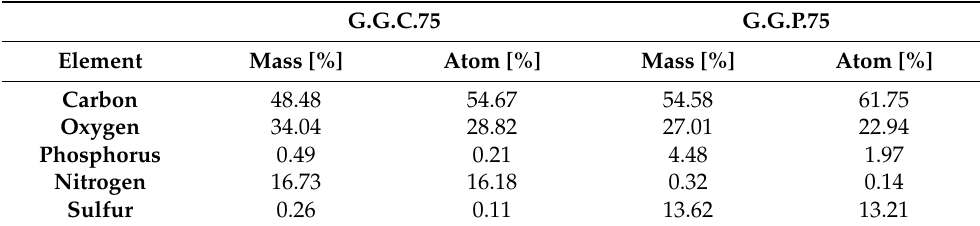
Table 9. Composite microstructure analysis of G.G.C.75 and G.G.P.75 percentage distribution of ele- ments in the study of breakthroughs of gelatin composites.